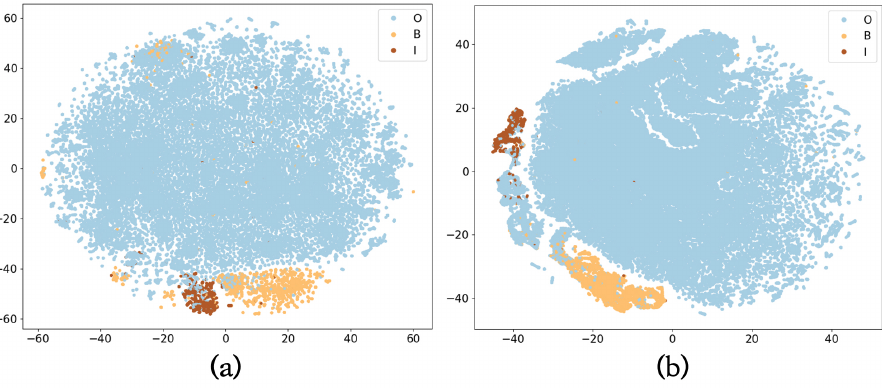
Figure 7. t-SNE visualization of BC5CDR-chem. The representations are extracted from language model F . ( a ) shows the result of the BERT baseline, and ( b ) shows the result of the proposed